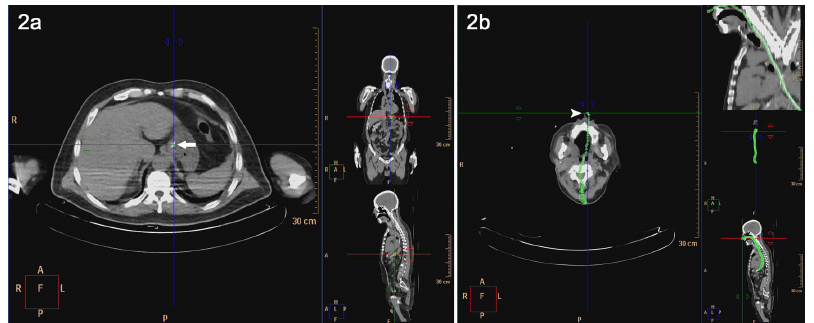
Figure 2. a. Pointed out the NG tube (Arrow) at the transverse level of the cardia. b. Every locations of NG tube are found on the transaxial images (5 mm thickness) with tracing upward till the nostril (Arrowhead). Curved multiplanar algorithm which represents the NG tube is reconstructed and measured.